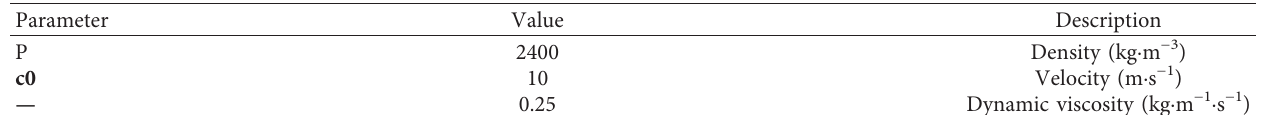
Table 2: Parameters of concrete.